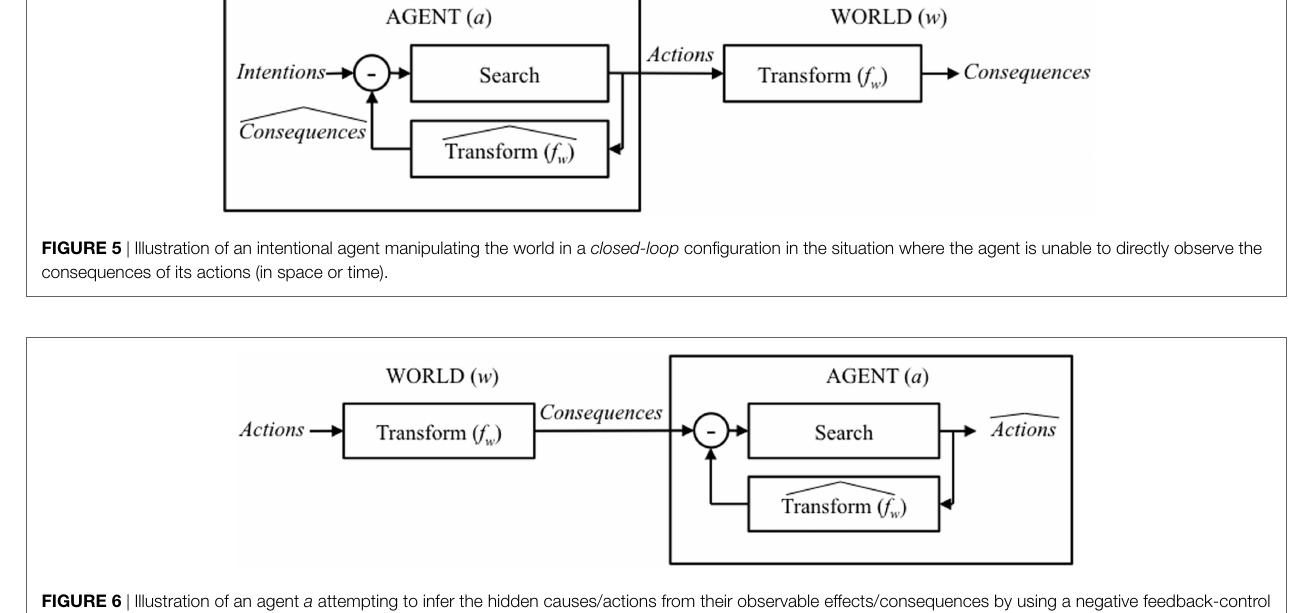
Frontiers in Robotics and AI |